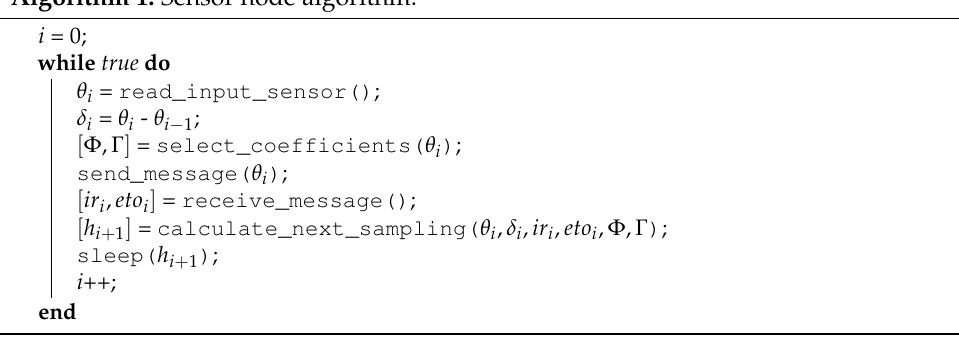
Algorithm 1: Sensor node algorithm.